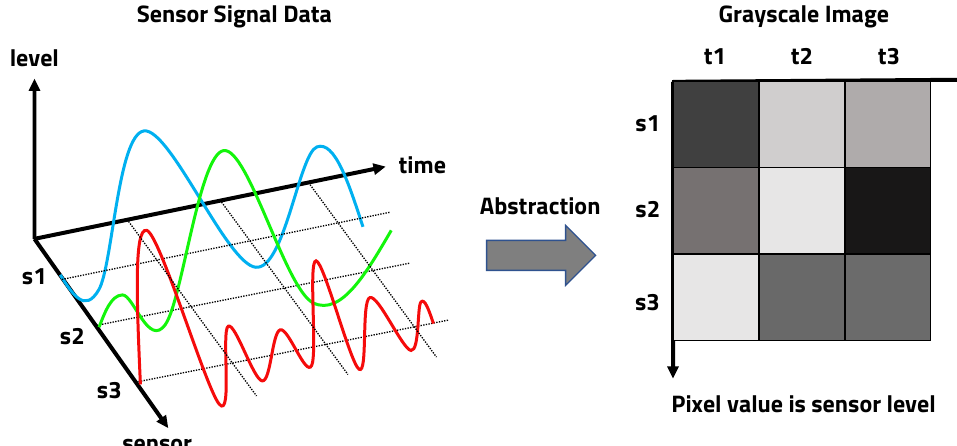
Figure 2. Conversion of sensor signal data to a grayscale